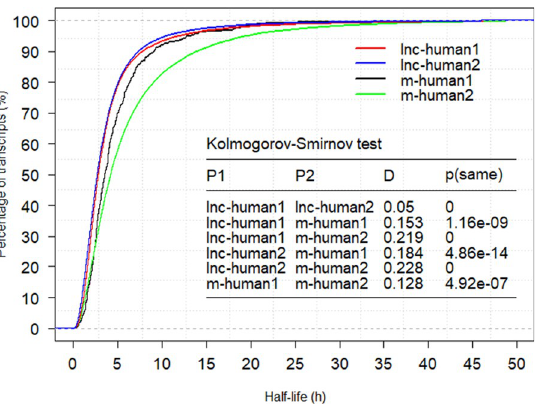
Fig 3. Half-life cumulative distributions for lnc-human1, lnc-human2, m-human1, and m-human2 (h).